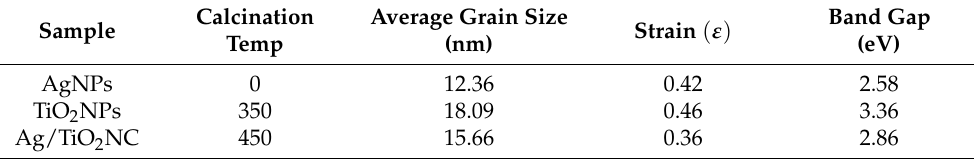
Figure 3. XRD spectra of pure and composite nanoparticles. Table 2. The grain size, strain, and band gap of pure and composite nanoparticles.